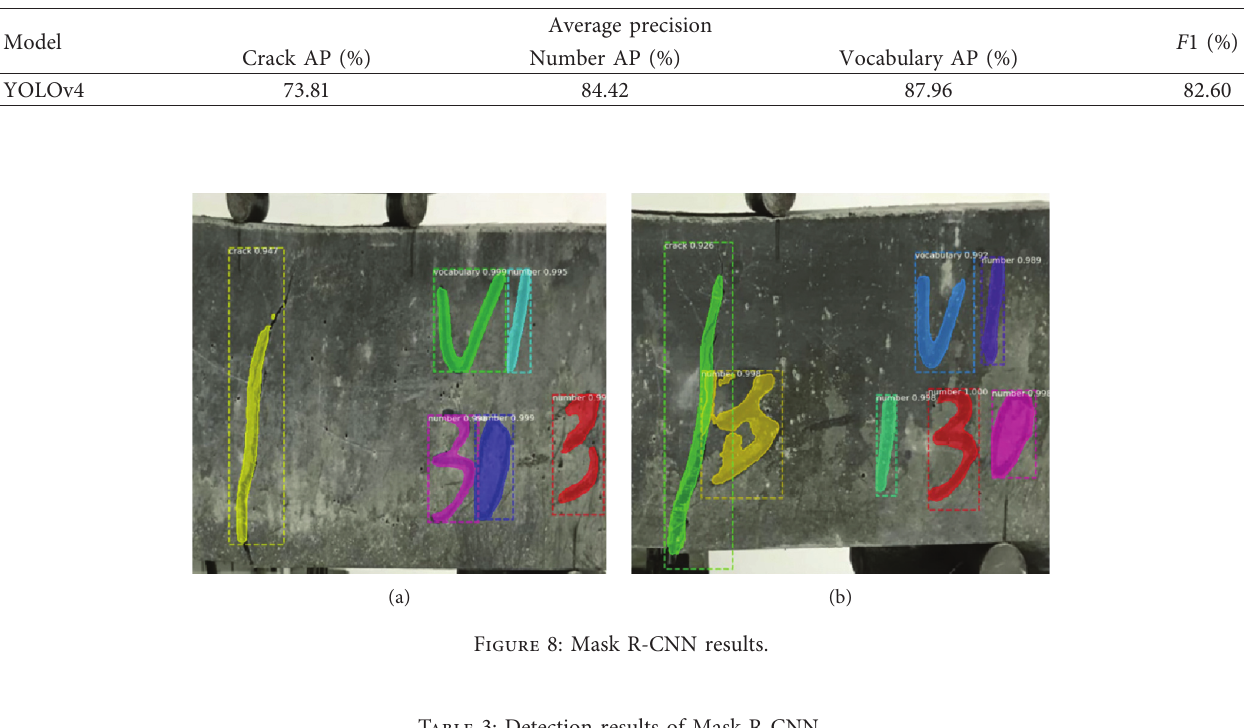
Figure 7: YOLOv4 results. Table 2: Detection results of YOLOv4.